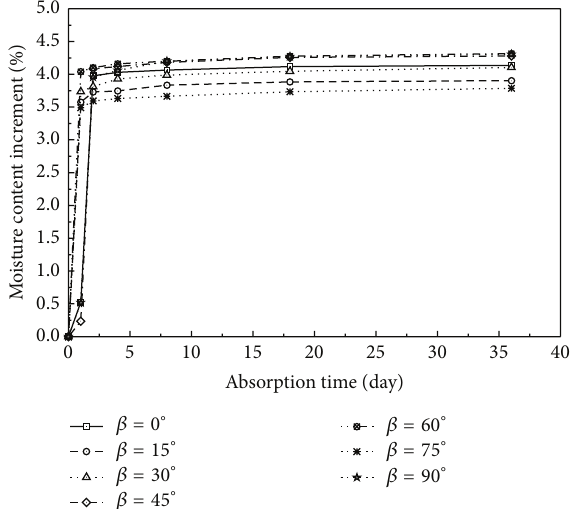
Figure 1: The moisture content increment of the specimens in the water saturated